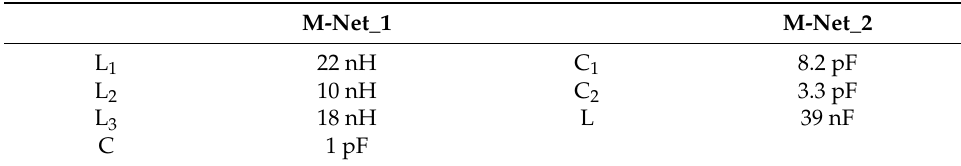
Figure 8. ( a ) The entire circuit of the antenna’s equivalent circuit connected to the rectifier through the M-Net_1 and ( b ) the M-Net_2. Table 3. The elements’ values of M-Nets.